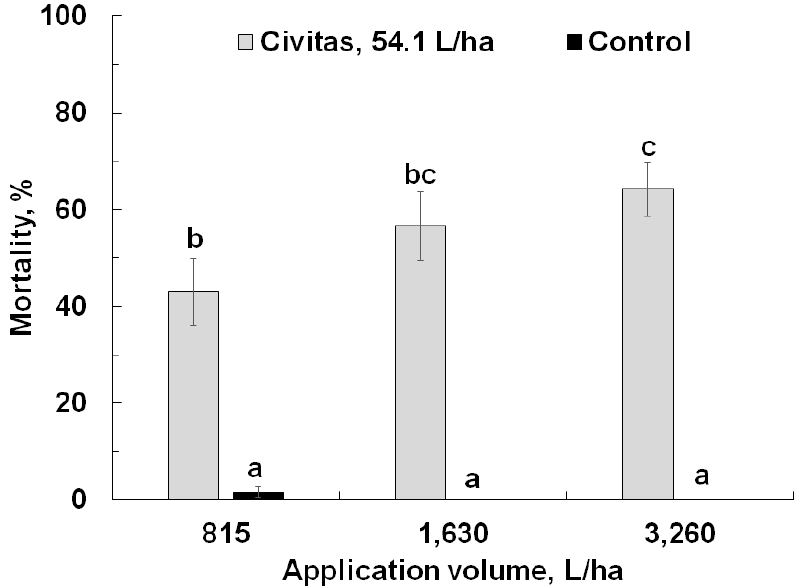
Figure 4. Effect of Civitas (54.1 L/ha) on mortality of Listronotus maculicollis adults at different carrier volumes. Means marked with the same letter do not differ statistically.